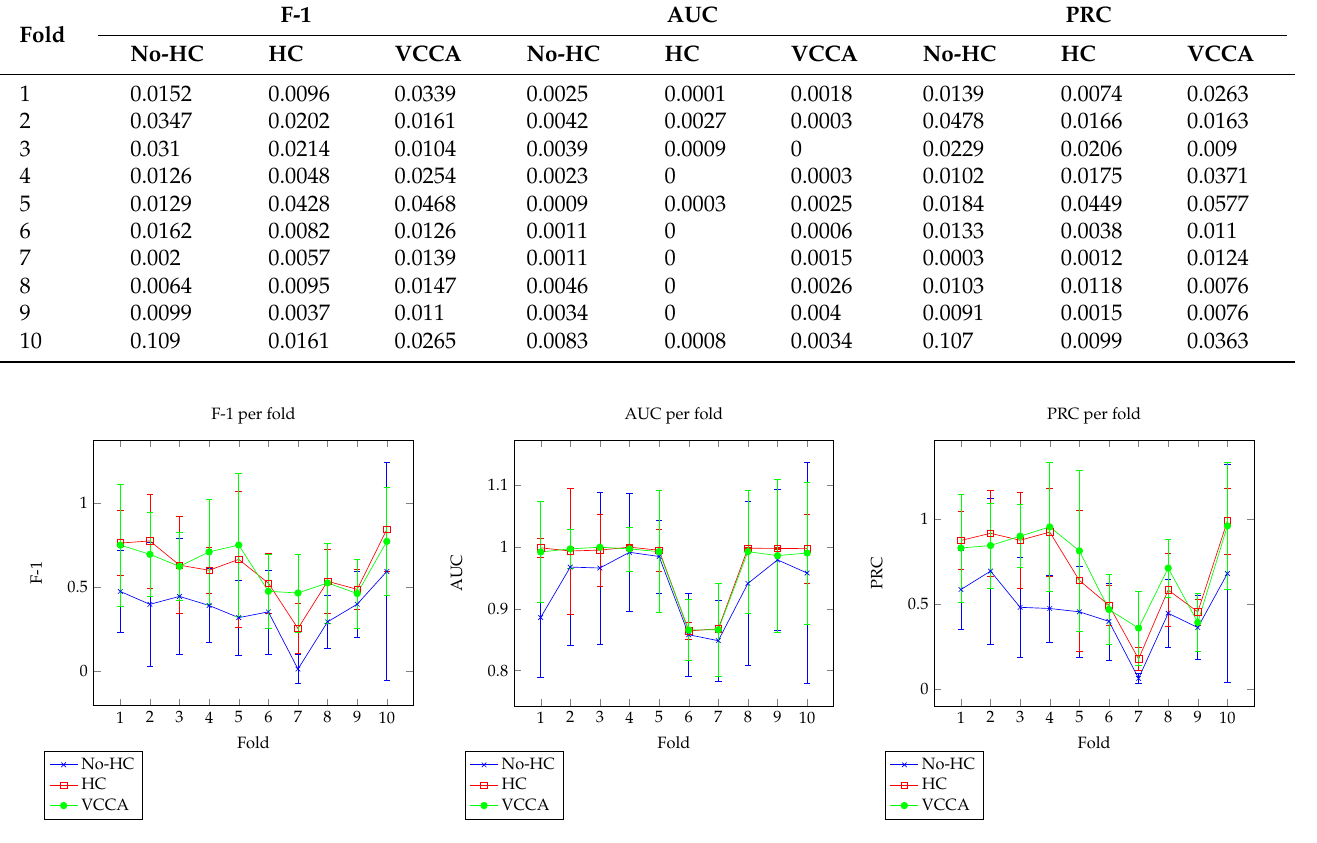
Figure 7. Mean values for the metrics applied on Dataset 1.